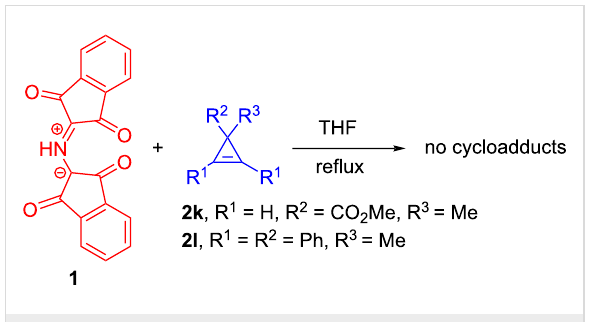
Scheme 6: The reactions of protonated Ruhemann's purple ( 1 ) with unstable cyclopropenes 2m – p